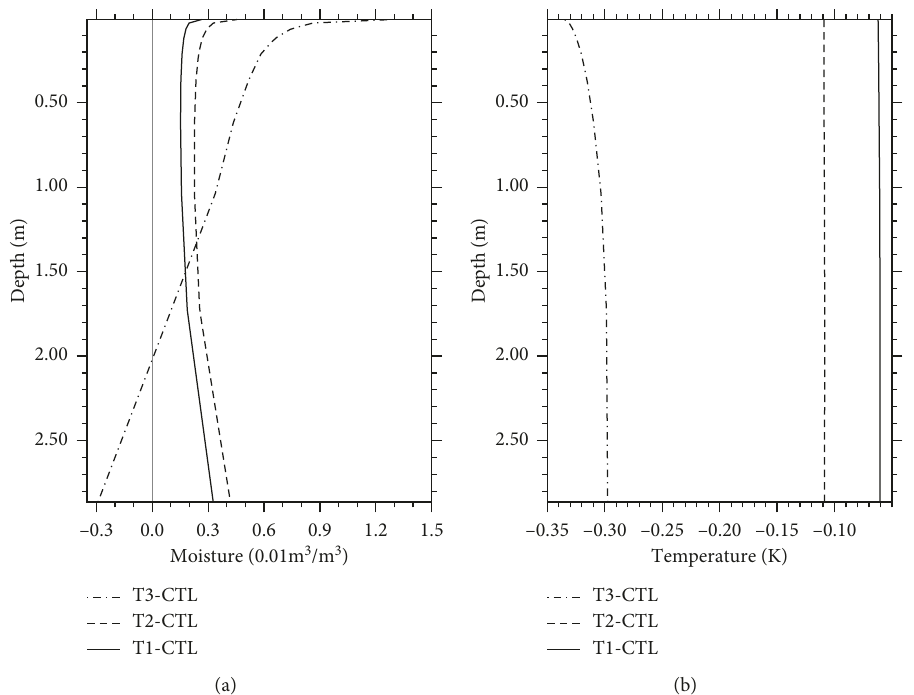
Figure 7: Mean profiles of (a) soil moisture difference and (b) soil temperature difference in the Taihang Mountains.